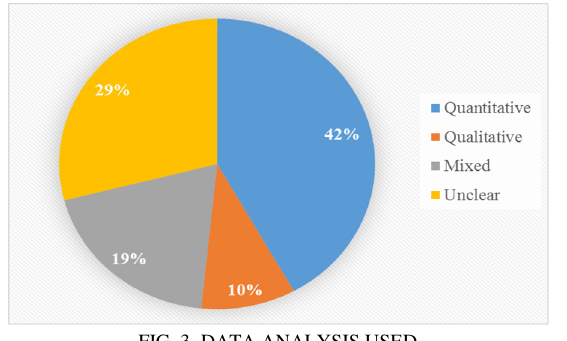
FIG. 3. DATA ANALYSIS USED